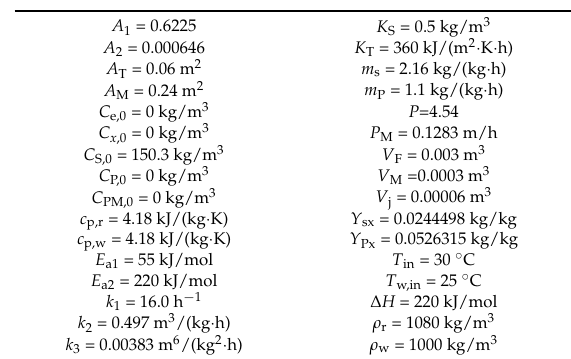
Table 1. Parameter values for the fermentation process